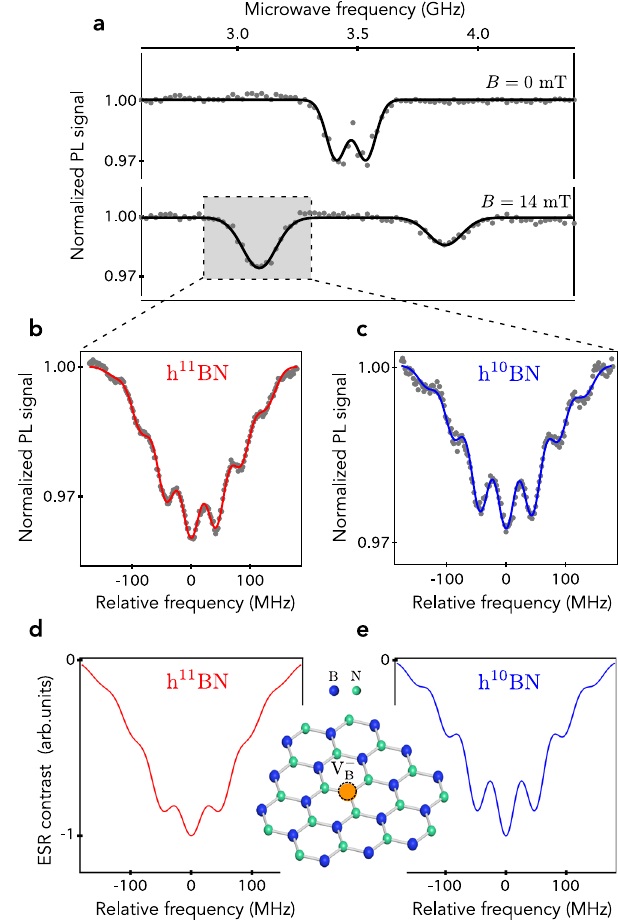
Fig. 2 Analysis of the hyper fi ne structure. a Optically detected ESR spectra recorded on the h 10 BN crystal at zero fi eld (top panel) and for a magnetic fi eld B = 14 mT applied along the c axis, i.e., perpendicular to the sample surface. b , c Hyper fi ne structure of the ESR line measured in b h 11 BN and c h 10 BN crystals. The solid lines are data fi tting with a sum of seven Gaussian functions. d , e Simulated hyper fi ne spectra of the V (cid:1) hBN obtained via the procedure described in the main text while using Δ s = 30 MHz. The inset shows the atomic structure of the V (cid:1) in